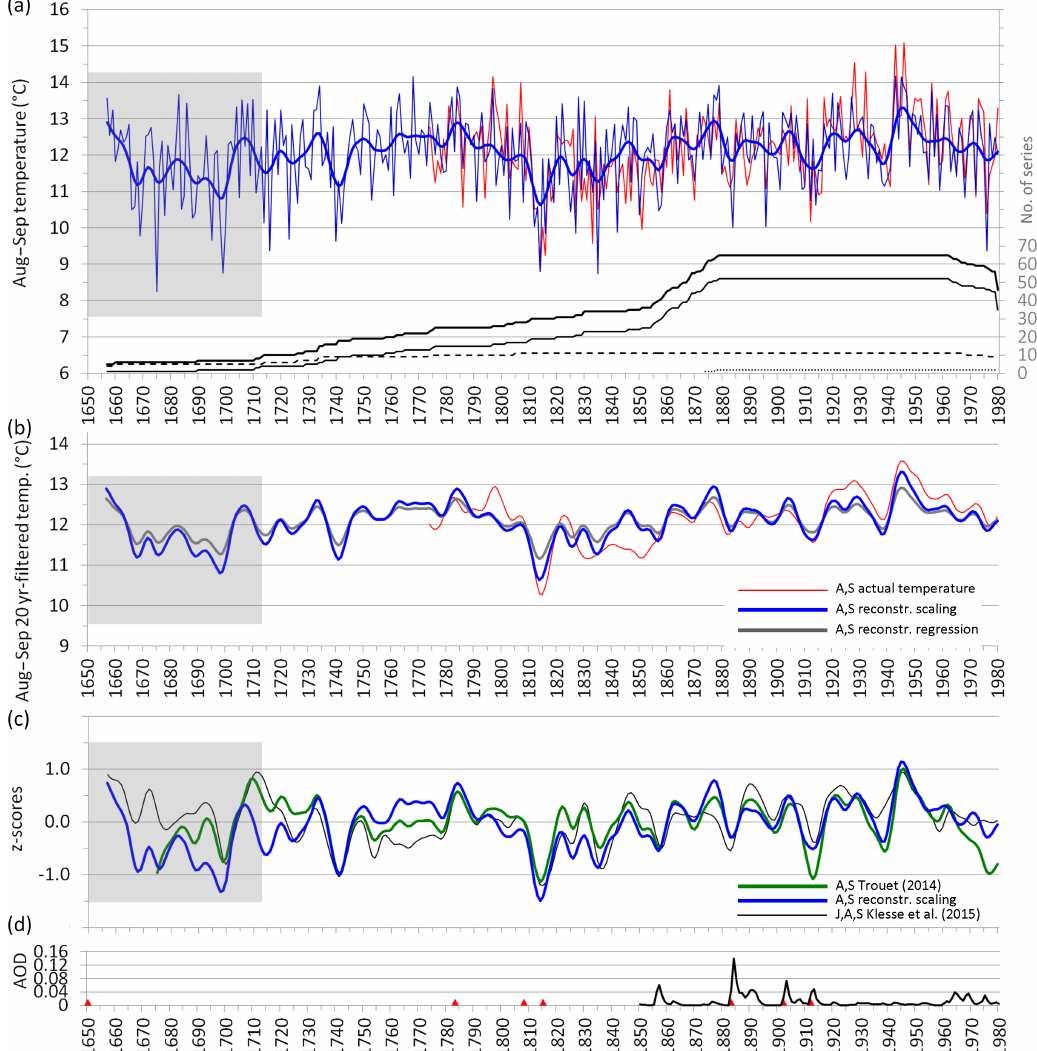
Figure 6. Reconstruction of late summer (August and September) temperature using the conifer MXD chronology with the scaling approach for the period 1650–1980 (a) . The bold black line indicates the total number of series (composed by a number of Abies alba (thin black line), Pinus leucodermis (dashed line) and P. nigra (dotted line) specimens). The low-pass-filtered series with a 20-year Gaussian smoother for both the reconstructions based on scaling and regression are also depicted (b) . The reconstructions were truncated when there were fewer than 5 trees, and the grey areas in the graphs depict the period where the conifer MXD chronology shows an EPS<0.79 (prior to 1714, fewer than 10 trees. EPS>0.85 from 1734). A comparison of the reconstructed late summer temperature (this paper) with the ones of Trouet (2014) and Klesse et al. (2015) using z scores series (calculated over the common period 1714–1980 with EPS>0.8 in all the original chronologies), filtered with a 20-year Gaussian low-pass filter (c) . At the bottom the annual mean of stratospheric aerosol optical depth (AOD) at 550nm for the Northern Hemisphere is reported (d) ; data set available at https://data.giss.nasa.gov/modelforce/strataer/; site accessed 30 May 2017; the red triangles mark major volcanic eruptions (volcanic explosivity index ≥ 6): in chronological order Kolumbo-Santorini, Grímsvötn, source unknown, Mount Tambora, Krakatau, Santa María and